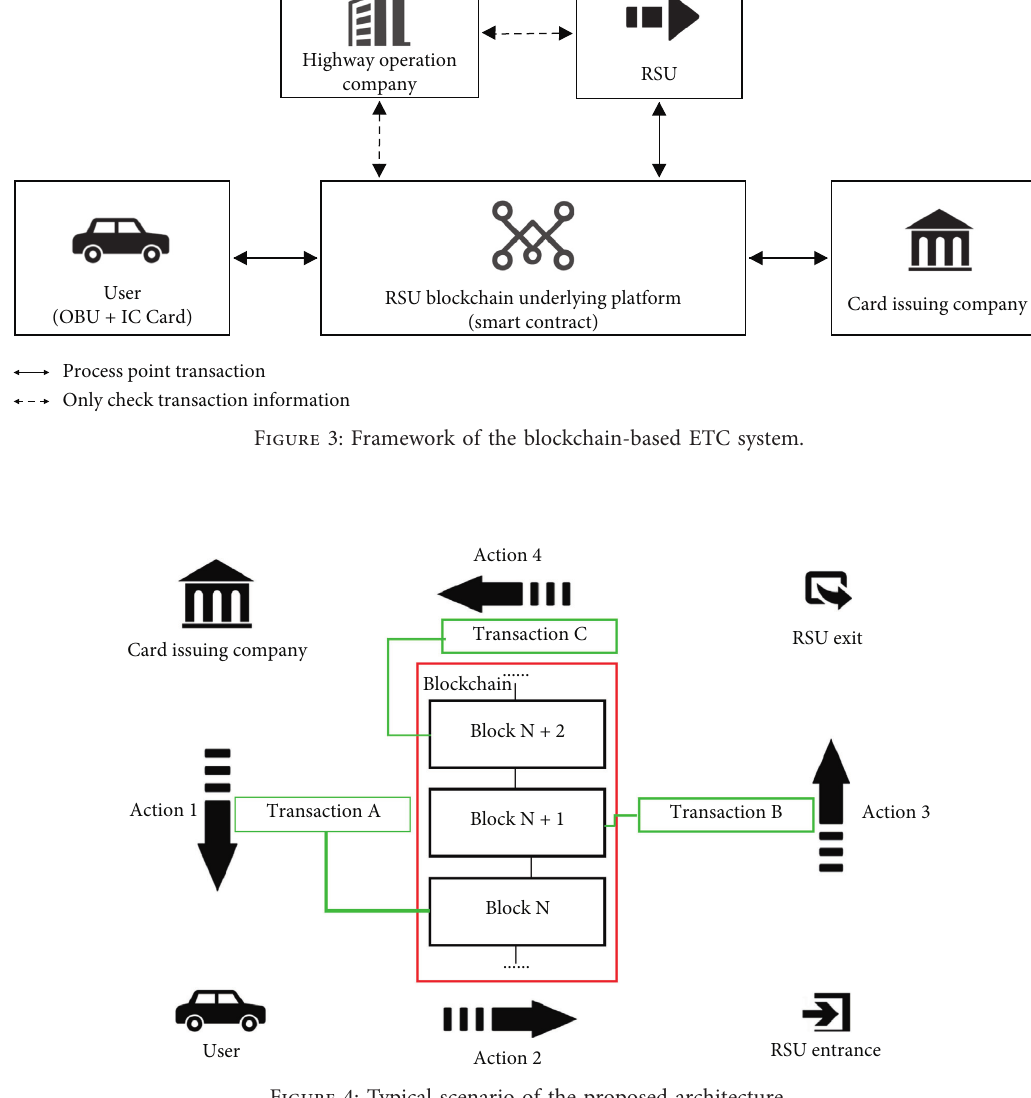
Figure 4: Typical scenario of the proposed